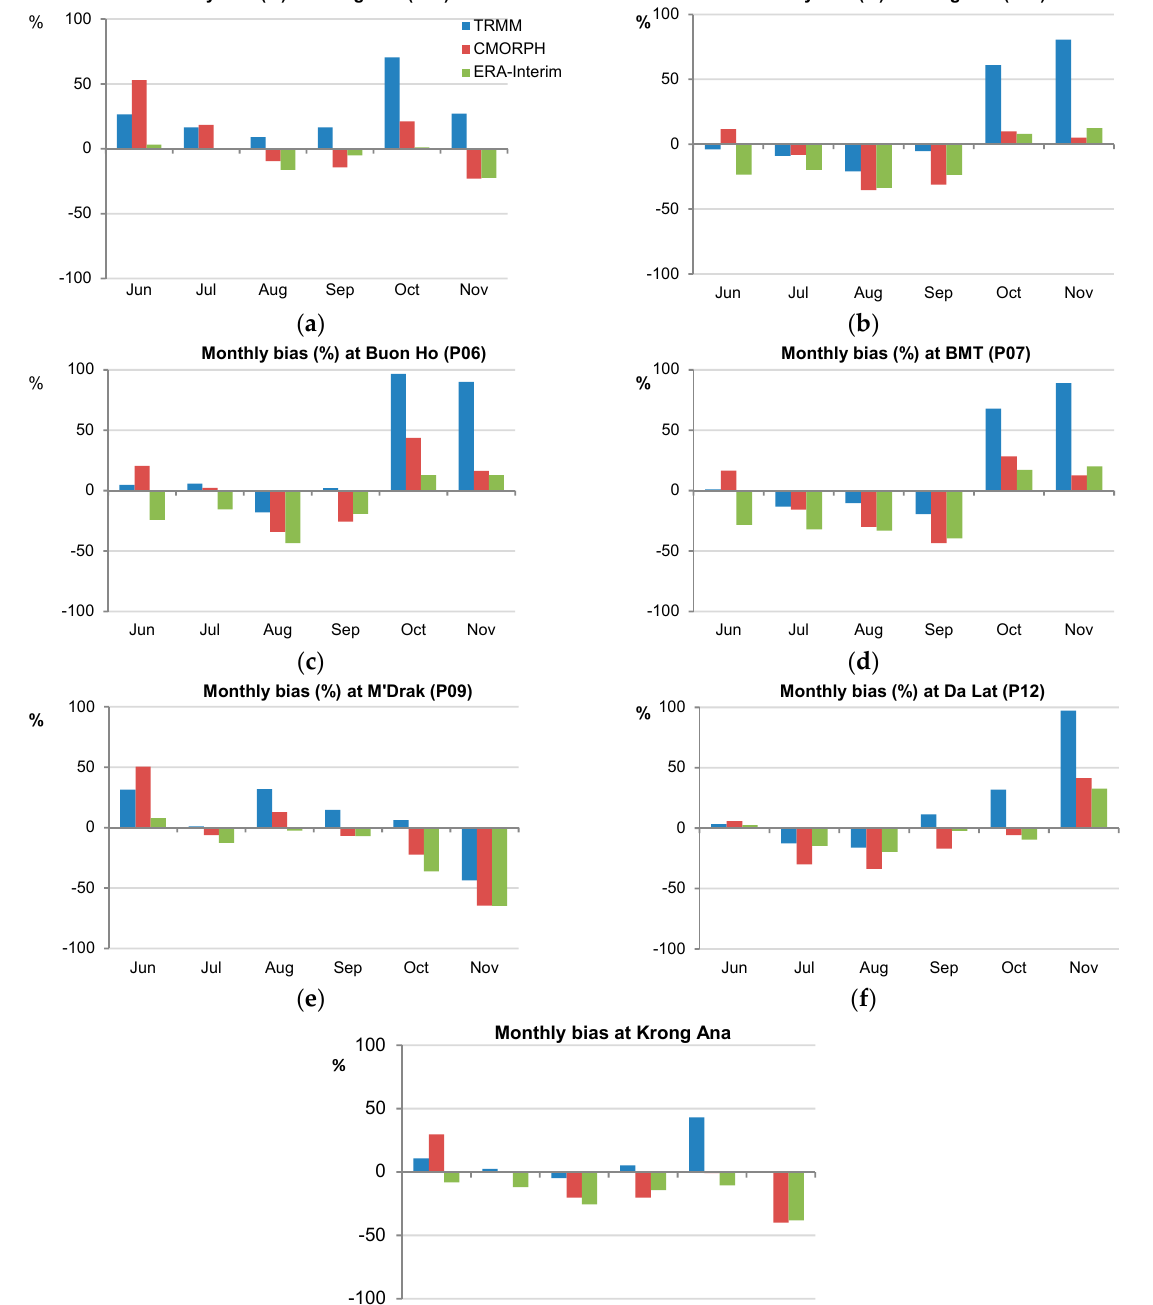
Figure 6. Monthly bias (%) of different SBRP data sets compared to GMP data in rainy season at different stations and Krong Ana Sub-catchment: ( a ) at Krong Buk station (P01), ( b ) at Giang Son station (P03), ( c ) at Buon Ho station (P06), ( d ) at BMT station (P07), ( e ) at M'Drak station (P09), ( f ) at Dat Lat station (P12), and ( g ) at Krong Ana Sub-catchment.